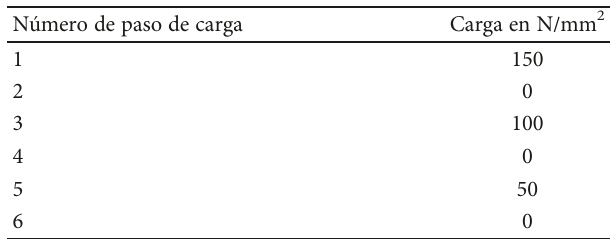
Table 2: Magnitudes of applied